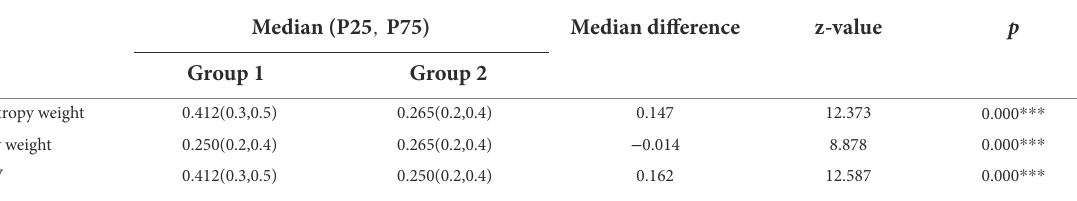
TABLE 4 Results of Wilcoxon analysis.